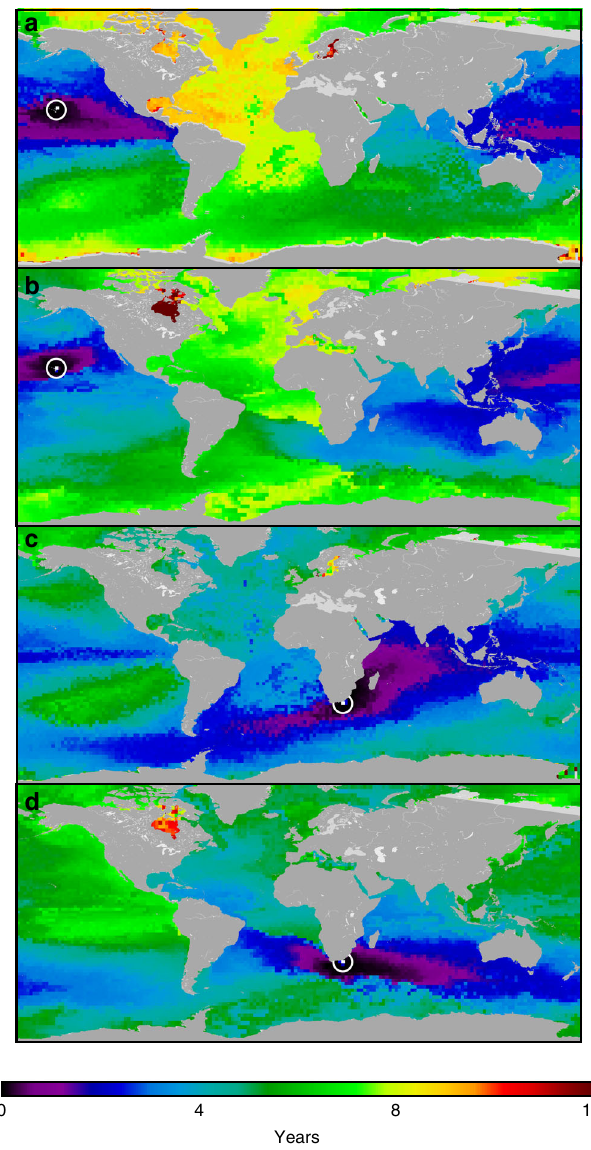
Fig. 5 Surface ocean transit times. Examples of minimum connection times to and from two locations identi fi ed by white circle-dots in two random Malaspina stations: off Hawaii ( a , b ) and off South Africa ( c , d ). Times ‘ to ’ are the shortest times taken for water from other patches to arrive at these locations. Times ‘ from ’ are the shortest times taken for water from these locations to go to all others. Minimum ocean transit time values were generated using Dijkstra ’ s algorithm (Methods